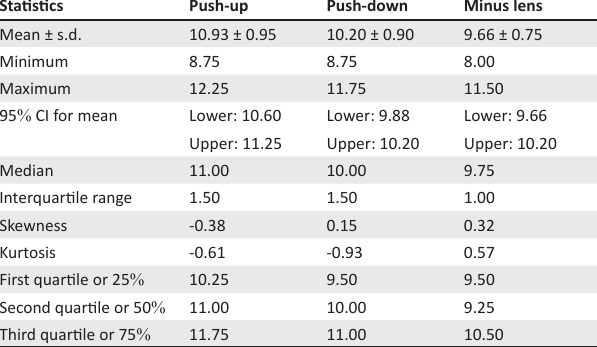
TABLE 1: Descriptive statistics for the amplitude of accommodation in dioptres with three different measuring methods. Statistics